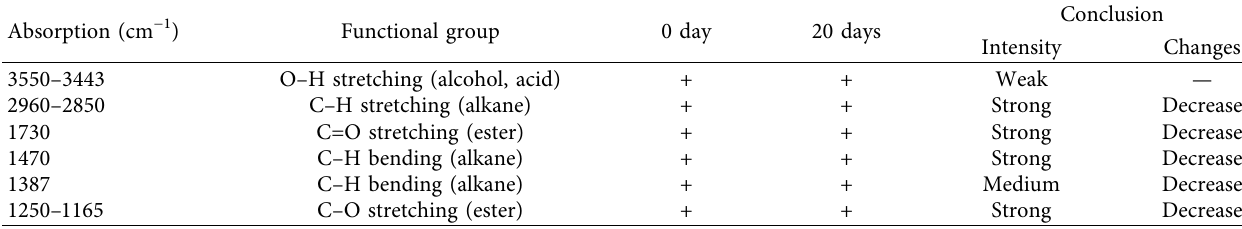
Table 1: The absorption bands in the IR spectra of acrylic coating containing 2.5 wt% nano-SiO Ca(OH) 2 environment for 20 days.